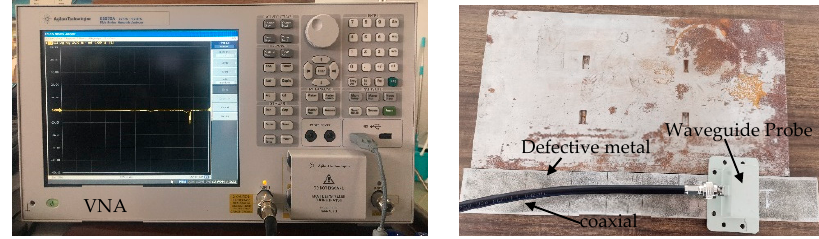
Figure 13. Schematic diagram of metal surface defect detection experiment.